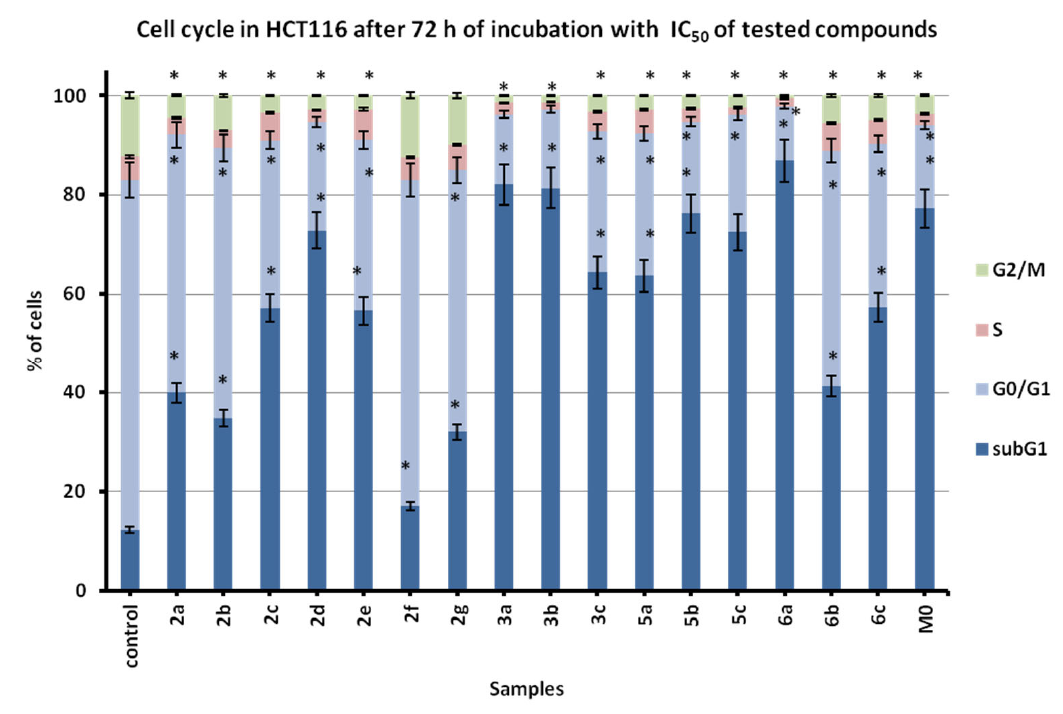
Figure 3. Cell cycle distribution in HCT116 cells after 72 h of incubation with doses of IC 50 or 100 µ M, respectively. SubG1 fraction represents apoptotic and dead cells. Results presented as mean from 3 experiments, +/ − SD. Statistical significance indicated by *; evaluated by t -test, where p < 0.05.